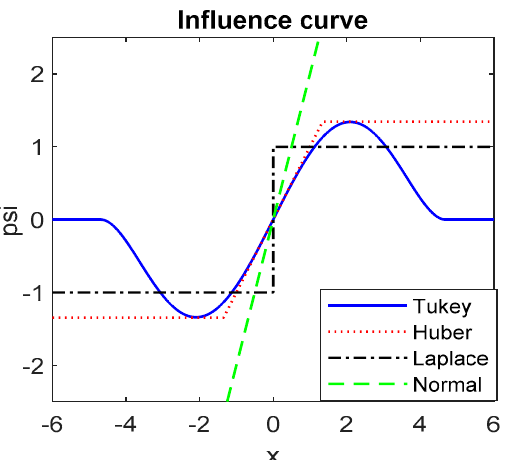
Figure 1. IC curves of M-estimators with squared loss (Normal), absolute deviation loss (Laplace), Huber loss, and Tukey’s biweight loss.